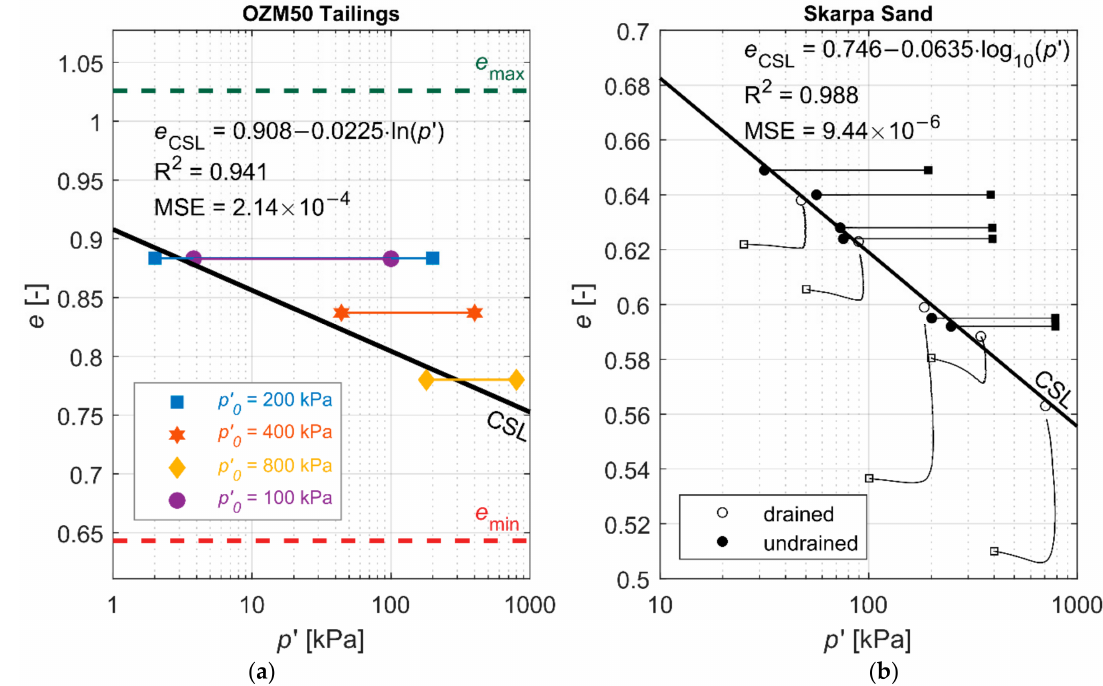
Figure 6. Critical state lines: ( a ) OZM50 tailings [56], ( b ) Skarpa sand, after